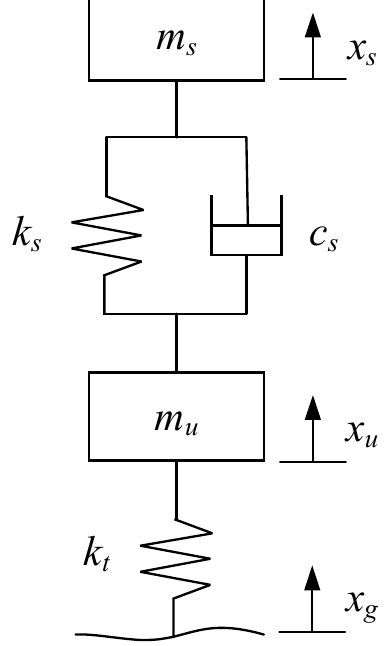
Figure 11. Quarter car dynamic model.